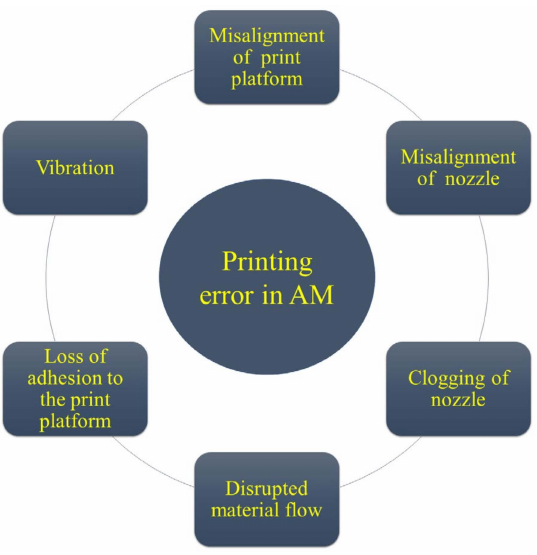
Figure 7. The printing error associated with additive manufacturing.